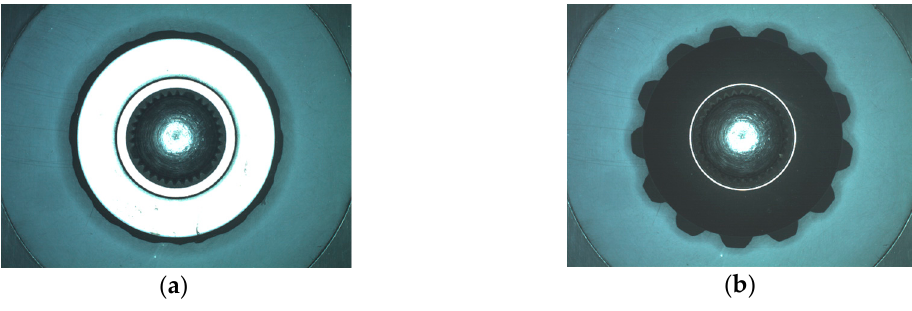
Figure 17. Bottom images of F 6 and A 4 : ( a ) Bottom of F 6 ; ( b ) Bottom of A 4 .